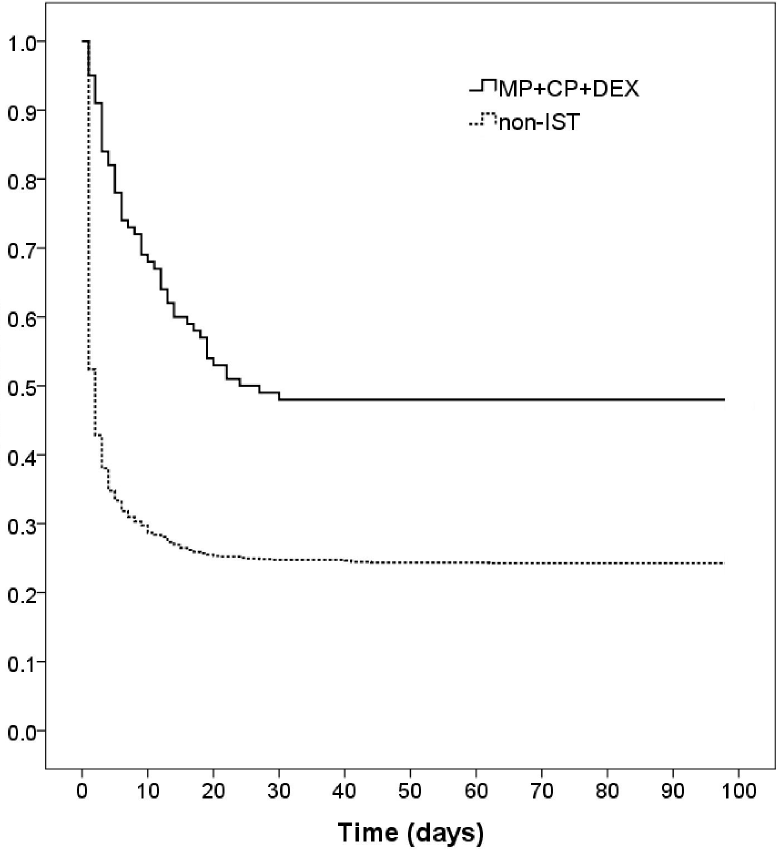
Figure 4. Kaplan-Meier survival plot of the MP + CP + DEX subgroup (n=100) versus the non-IST group (n=1046, log rank test, P , 0.001). Abbreviations: MP: Methylprednisolone; CP: Cyclophosphamide; DEX: Dexamethasone; IST: Immunosuppressive treatment.